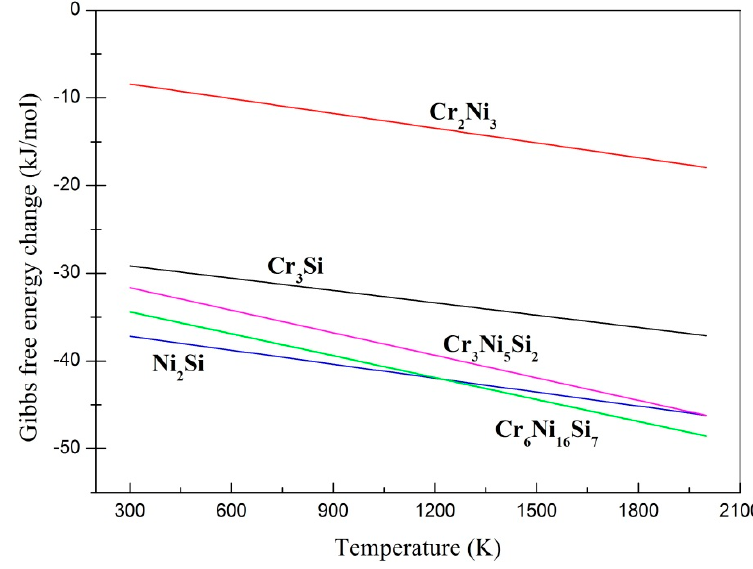
Figure 4. The Gibbs free energy of the synthesis reactions verse temperature.